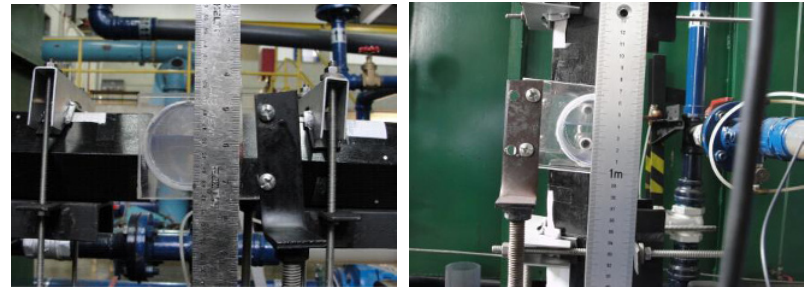
Figure 2. (Left) Detectors in horizontal position showing the fluid level (water and air). (Right) Detectors in vertical position showing again the fluid